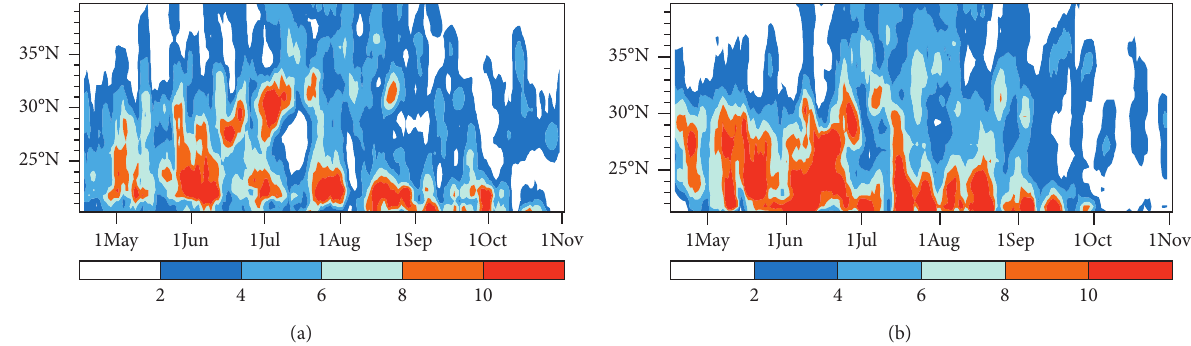
Figure 9: Latitude-time cross sections of 5-day running mean precipitation (mm/day) averaged between 110 ° E and 120 ° E in typical years of the epoch: (a) 1979–93 and (b)